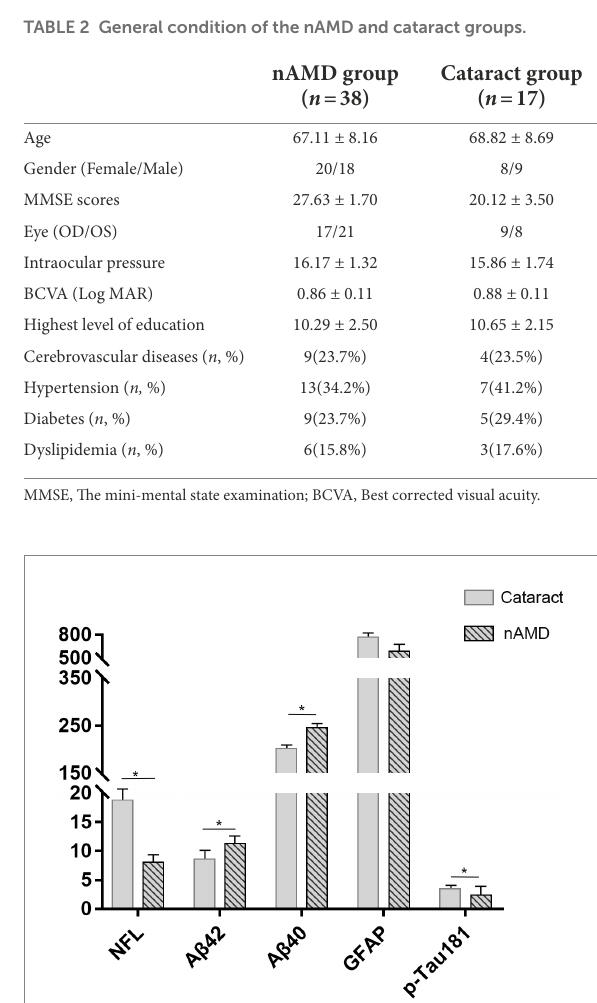
FIGURE 1 The difference evaluation of AD-related biomarkers in the two groups. Higher concentrations of NfL and p-tau181 but lower concentrations of A β 40 and A β 42, while similar concentrations of GFAP in AH of cataract group compared to those in nAMD group. * p <